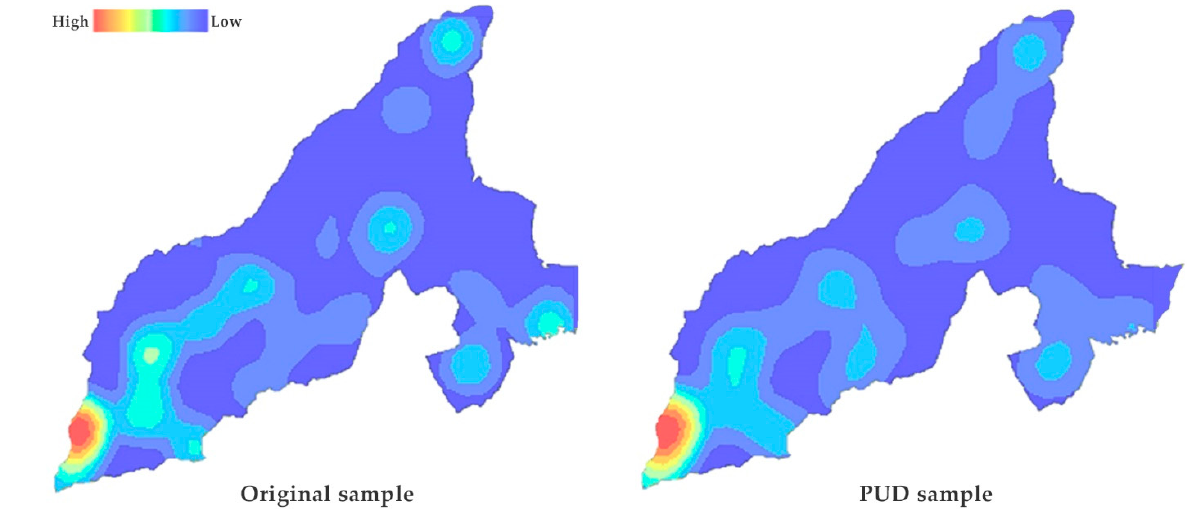
10 of 14 Figure 7. Jackknife test applied to environmental values for each of the samples. 3.3. Actual Demand and Correlation The photo density from the actual demand provides similar results for both the orig- inal sample and the PUD (Figure 8). In both cases, there is a high concentration of photo- graphs in the southwest area, although there is a proportionate distribution of lower con- centrations throughout the rest of the Lozoya Valley. It is also noteworthy that in both samples, the concentration in the southeastern area is significant. The correlation matrix between these maps and their corresponding MaxEnt models gives a value of 0.30940 in the case of the original sample and 0.435 in the case of the PUD sample. That is, in both